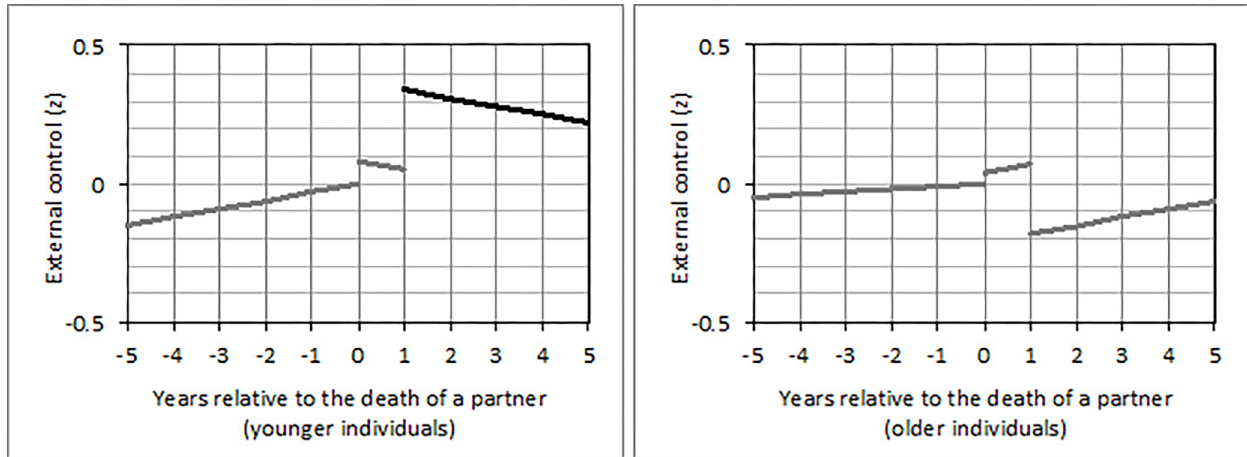
Fig 5. Changes of external control beliefs from five years before until five years after the death of a partner in (a) younger and (b) older individuals who experienced this loss between 1991 and 1999. Note . A detailed description of the figure can be found in Fig 2. The third line in (a) is marked in black because the long-term effect reached statistical significance ( p < .05) only in younger but not in older individuals.